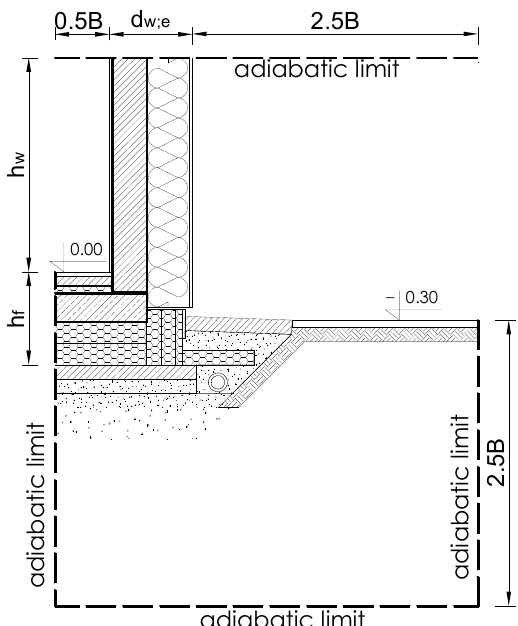
Figure 9. Geometry of the wall ‐ to slab ‐ on ‐ ground calculation model.